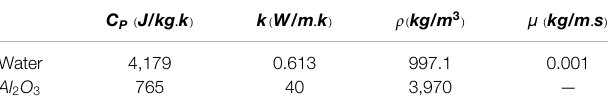
TABLE 1 | Thermophysical properties of water and Al 2 O 3 Teng et al. (2010), Khanafer and Vafai (2011), Aghakhani et al. (2019). C P ( J / kg . k )